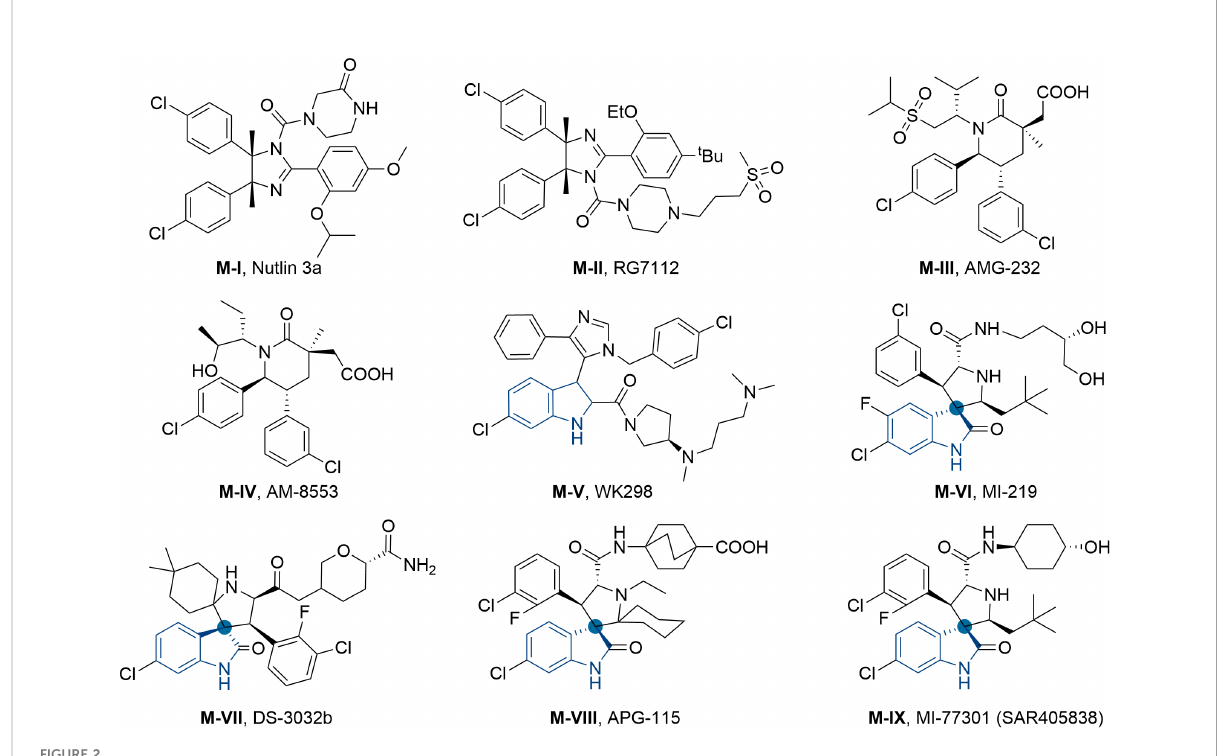
FIGURE 2 Structures of several representative MDM2 inhibitors.